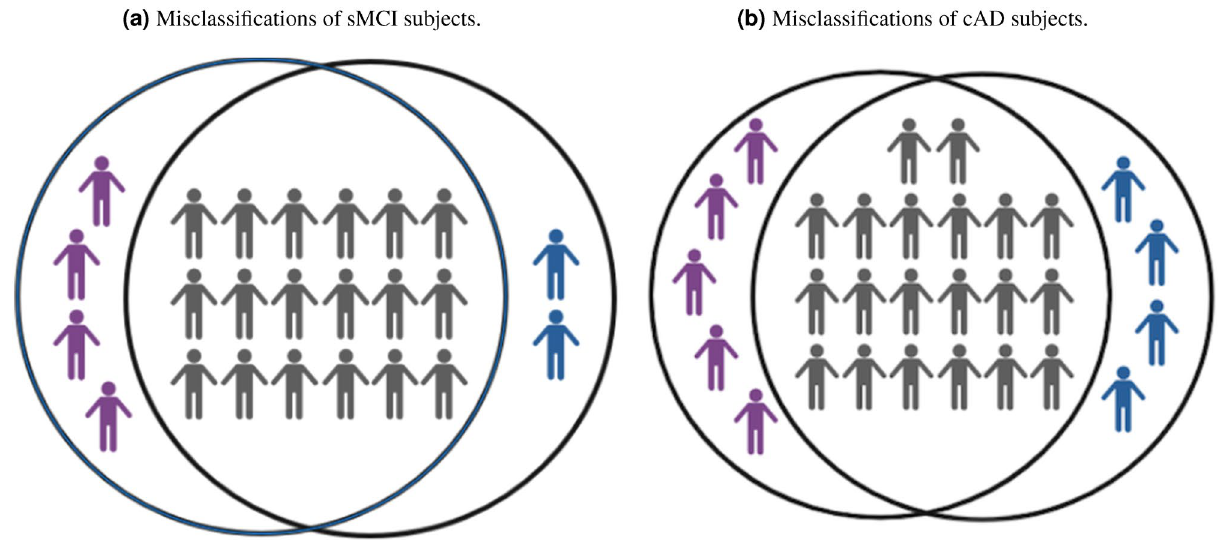
Figure 2. The figure illustrates the two models’ overlap in misclassified sMCI ( a ) og cAD ( b ). Gray symbols represent subjects for which the two models overlapped in misclassification. Purple and blue symbols represents additional subjects misclassified by the Random Forest model and the ensemble model, respectively.